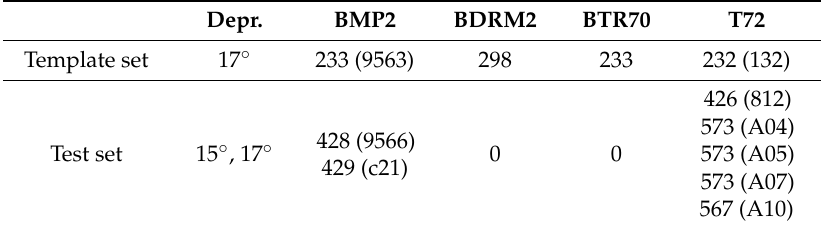
Table 5. Template and test sets with configuration variants.